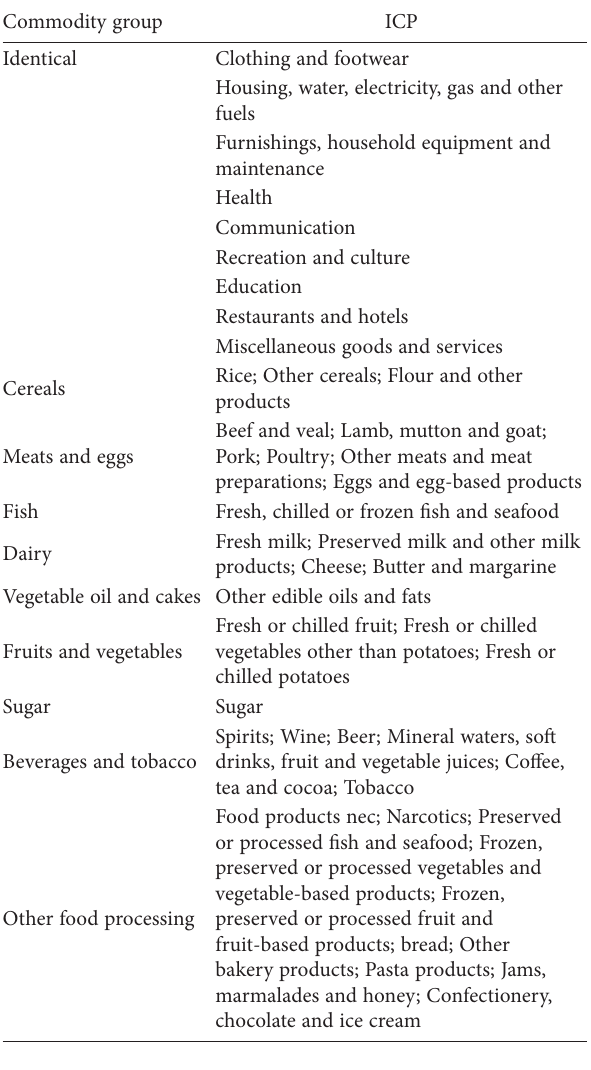
Table 1. Commodity groups in estimation and ICP detail. Commodity